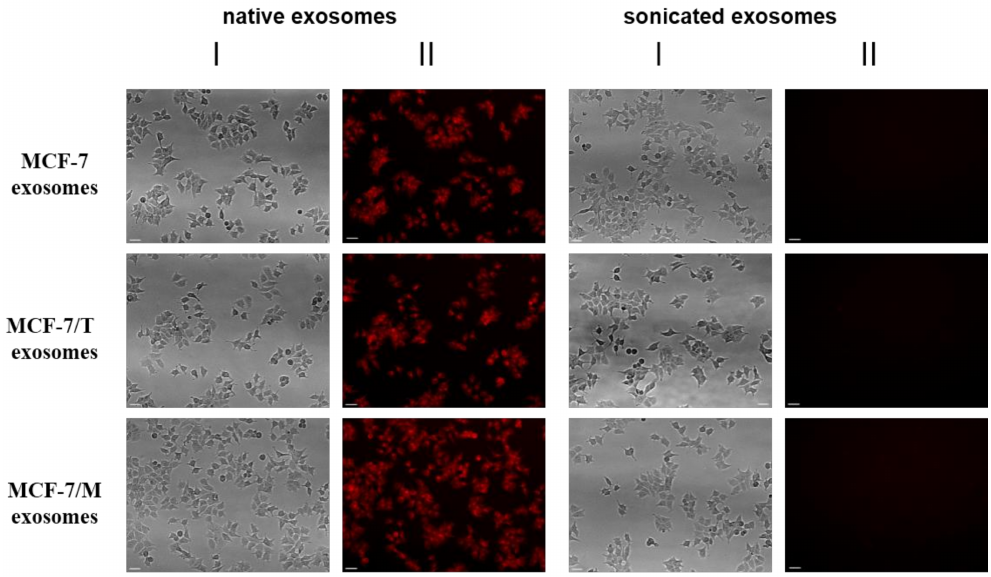
Figure 2. The transmission electron microscopy of the exosomes. Exosomes were prepared from the conditioned medium by the differential ultracentrifugation, labeled by the gold nanoparticles, and imaged as described in Methods. ( A – C ) Wide-field images of the exosomes from MCF-7, MCF-7/T and MCF-7/M cells correspondingly. ( D – F ) The magnified fragments, scale bar 100 nm. ( G ) Exosome size distributions obtained by processing of the TEM images. ( H ) The labelling specificity of the exosomes in the three samples obtained from MCF-7, MCF-7/T and MCF-7/M cells. The error bars correspond to